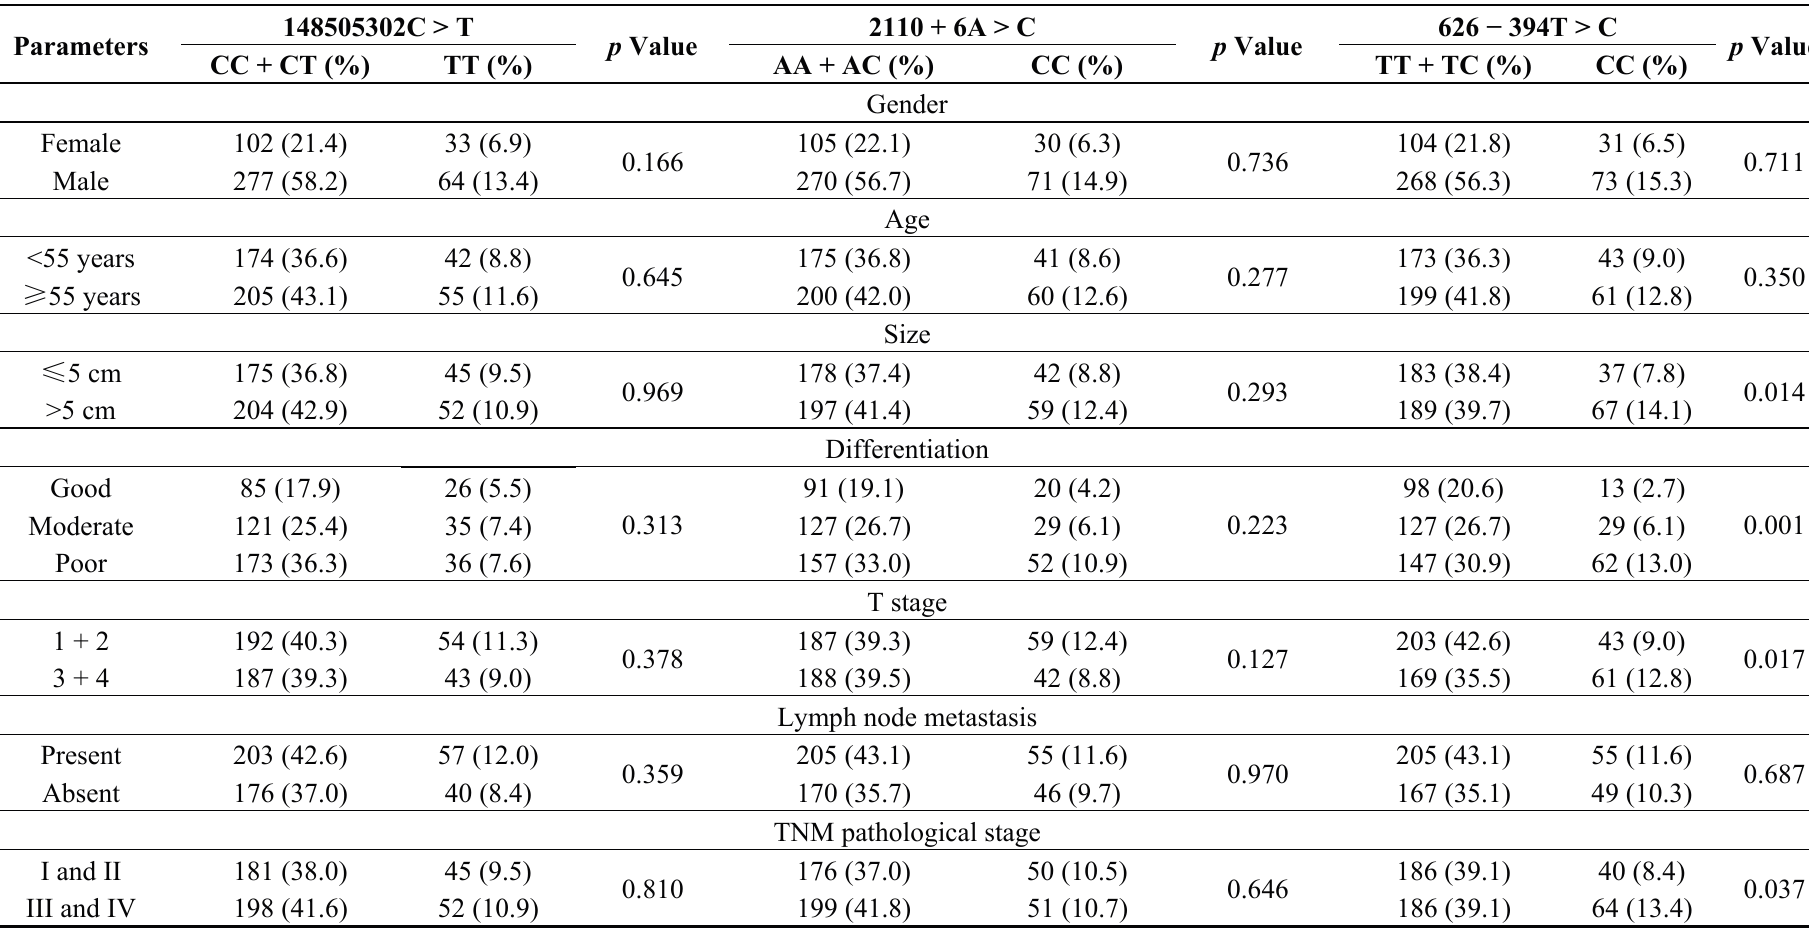
Table 3. Clinicopathological relevance of EZH2 gene 148505302C > T, 2110 + 6A > C and 626 − 394T > C polymorphisms in ESCC.